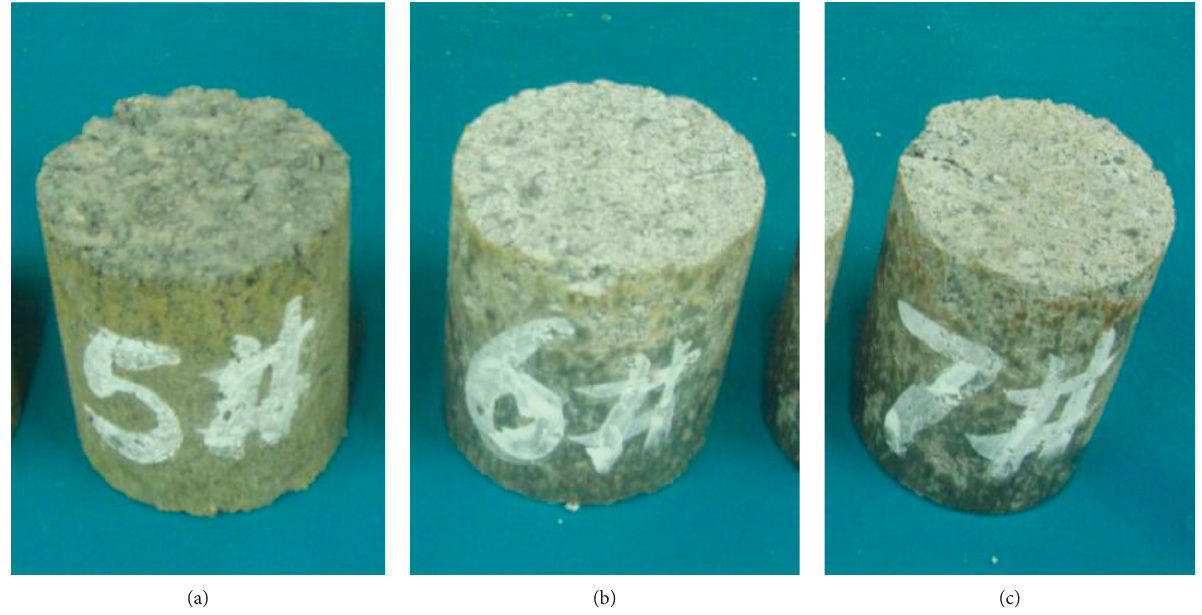
Figure 3: Rock specimens. (a) Specimen cemented by clay; (b) specimen cemented by gypsum; (c) specimen cemented by